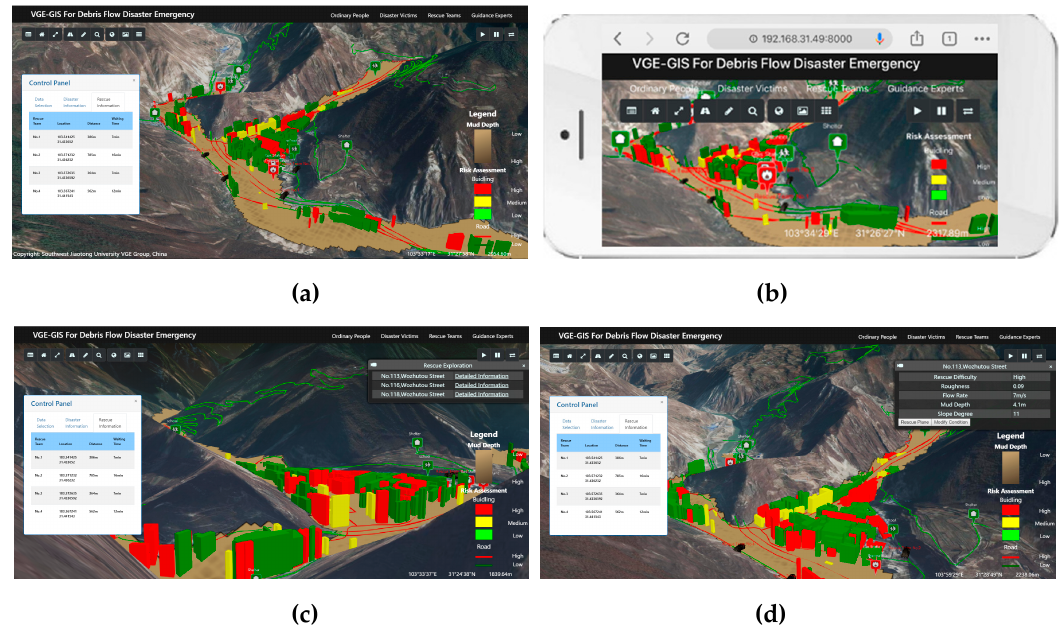
Figure 10. Virtual debris flow disaster environment for guidance experts on desktop and mobile terminals: ( a ) Prototype system run on a desktop terminal; ( b ) prototype system run on a mobile terminal; ( c ) step 1 of the interactive and explorative rescue process; ( d ) step 2 of the interactive and explorative rescue process .